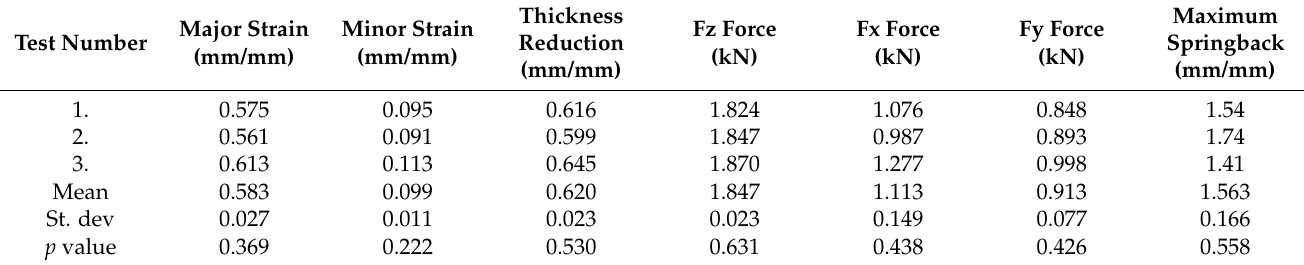
Table 8. Results for double side welded blanks processed by SPIF truncated cone shape.